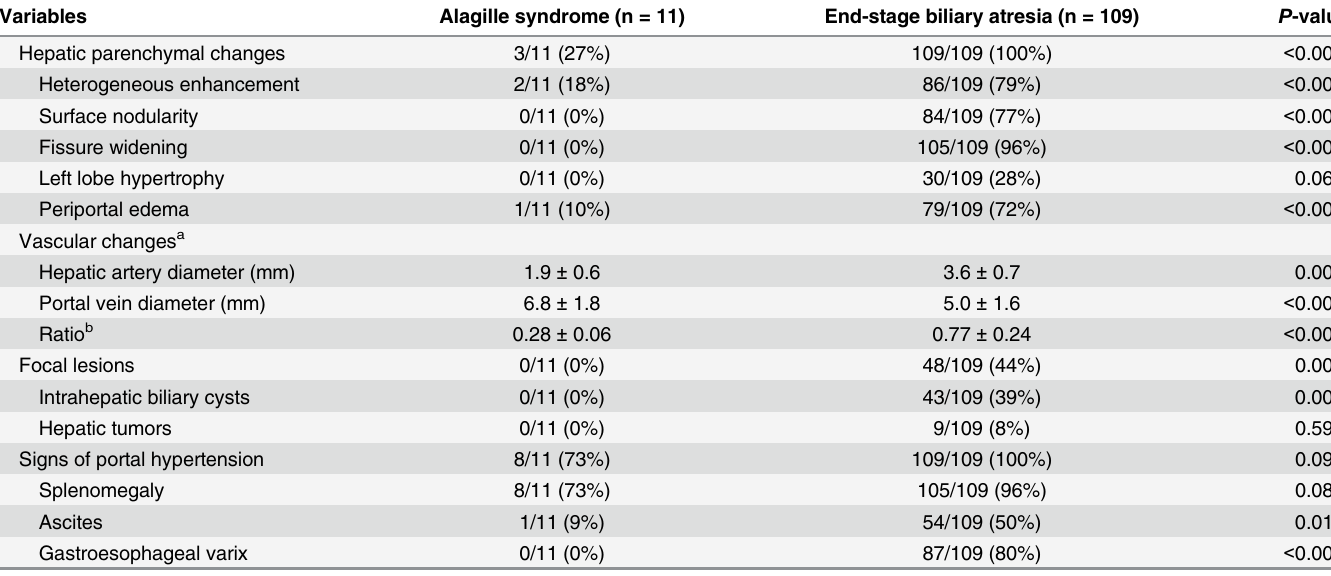
Table 3. CT imaging findings in patients with Alagille syndrome and end-stage biliary atresia.